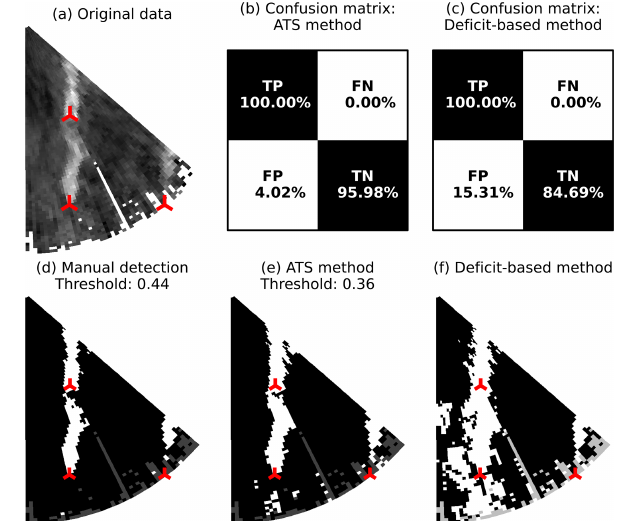
Figure 16. Scan 60 (parallel-wake subset), wake identification. (a) The original data in the Cartesian coordinates, (b, c) confusion matrices for the ATS and deficit-based methods, (d) manual thresh- old selected in a way to reduce noise but keep a general shape of the wakes, and (e, f) thresholds estimated by the ATS and deficit-based methods.